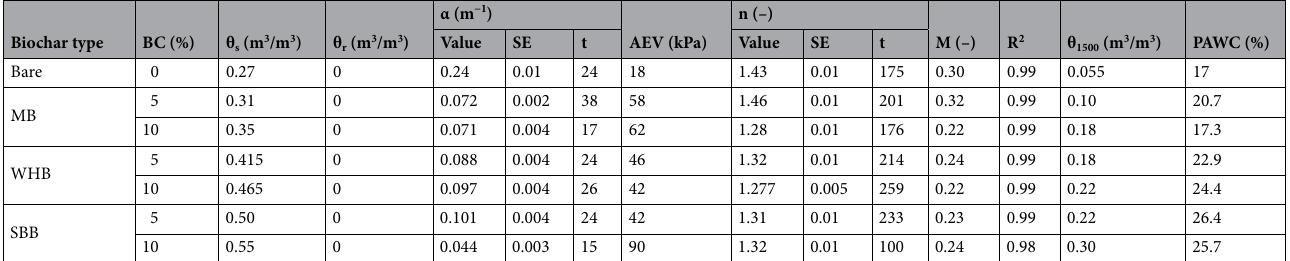
Table 3. Fitting parameters of SWRCs fitted using van Genuchten 54 model. BC biochar content, AEV air entry value, PAWC plant available water content, SE standard error, t t value.